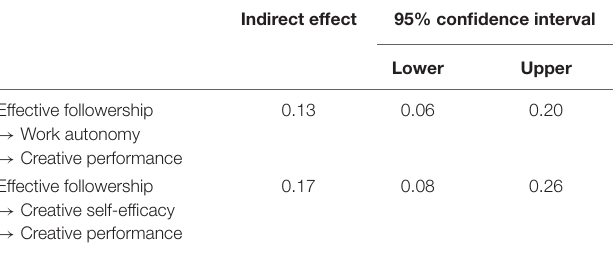
TABLE 2 | Indirect effect and confidence intervals